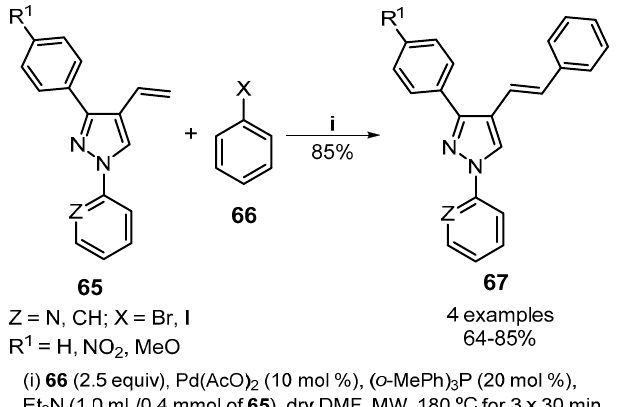
Scheme 19. Mizoroki–Heck coupling of 4-vinylpyrazole 65 with halobenzenes 66 to prepare ( E )-1,3- disubstituted-4-styryl-1 H -pyrazoles 67 [45].